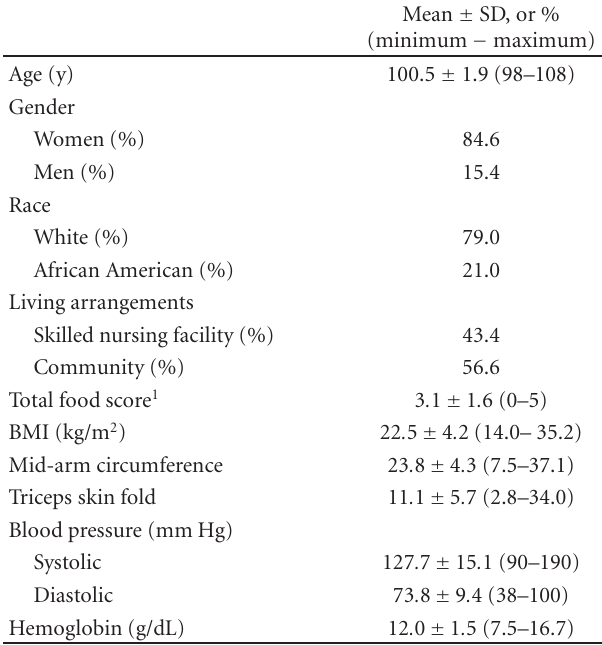
Table 1: Characteristics of study